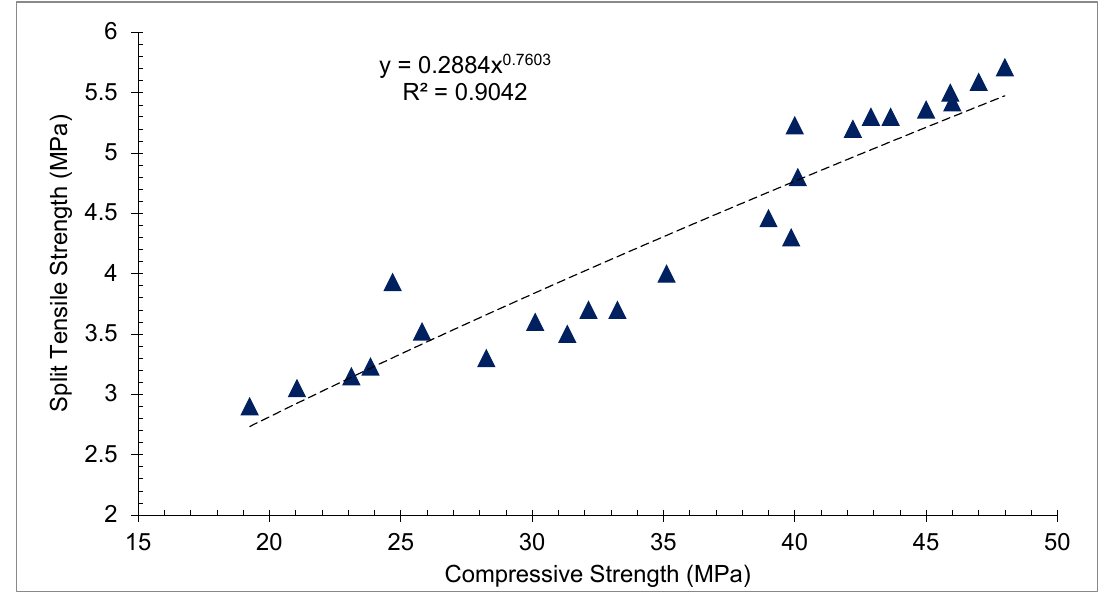
Figure 11. Correlation between CMS and TS: data source [45].